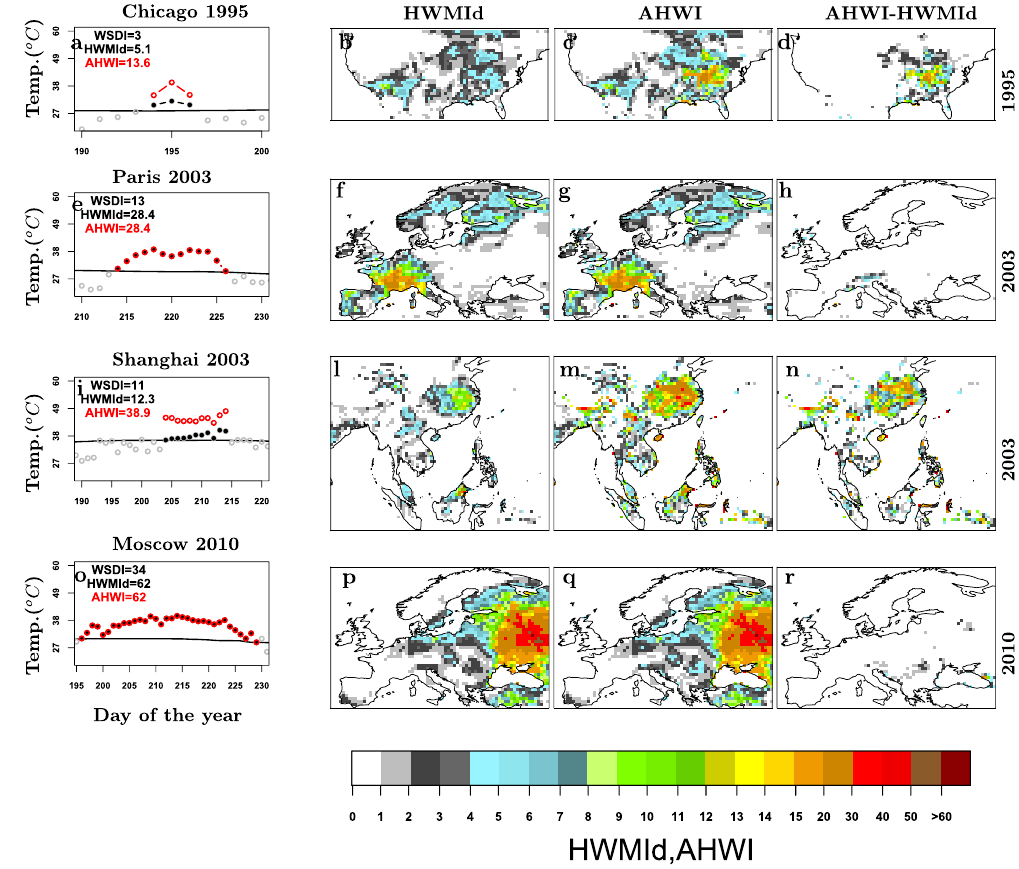
Figure 1. Historical heat waves and humid heat waves across world regions with different climates and their HWMId and AHWI spatial distribution. The panels ( a , e , i , o ) show time series of heat waves that occurred in specific locations reporting the values of HWMId, AHWI and the duration, calculated by means of the Warm Spell Duration Index (WSDI, see method). Black line is the 90 th percentile daily threshold (see method). Open grey circles are the temperature values of the days. Full black circles are the days in the heat wave. Red open circles represent the apparent temperature values calculated, for each day composing the heat wave, by means of the Heat Index (see method). The maps in ( b , f , l , p ) and ( c , g , m , q ) represent the spatial distribution of the HWMId and AHWI, respectively. The maps in ( d , h , n , r ) show the spatial distribution of the differences between AHWI and HWMId. This figure has been produced using R version 3.3.2